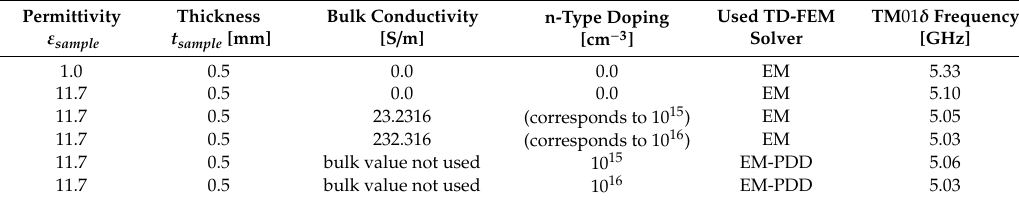
Table 2. Resonant frequencies of SPDR for TM01 δ mode for di ff erent sample types and simulated by di ff erent solver